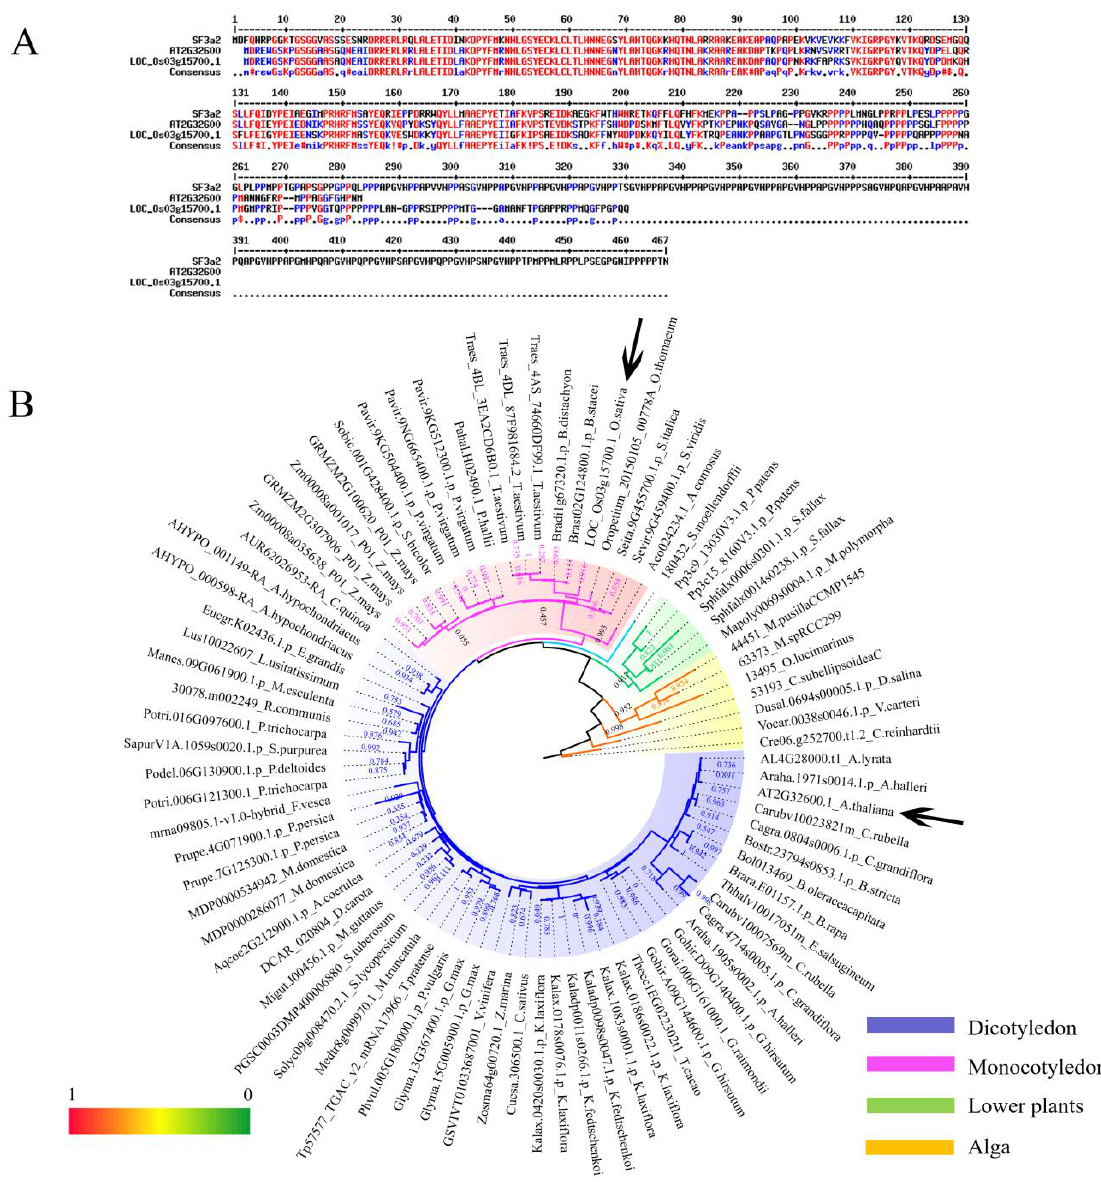
Figure 1. Phylogenetic analysis of the SF3a2 genes in the plant lineage. ( A ) Sequence alignment of human SF3a2 , Arabidopsis AT2G32600 , and rice LOC_Os03g15700.1 . ( B ) Phylogenetic analysis of SF3a gene family using maximum likelihood methods as implemented in software PhyML v3.0. The evolutionary tree consists of 83 genes selected in this research. Different colors represent different floristic compositions, as marked at the bottom right side of the picture. Bootstrap values are marked at the branches. The assigned genes of Arabidopsis thaliana and Oryza sativa are pointed out by black arrows. The Latin abbreviations and the specific names of every gene are listed in Supplementary Table